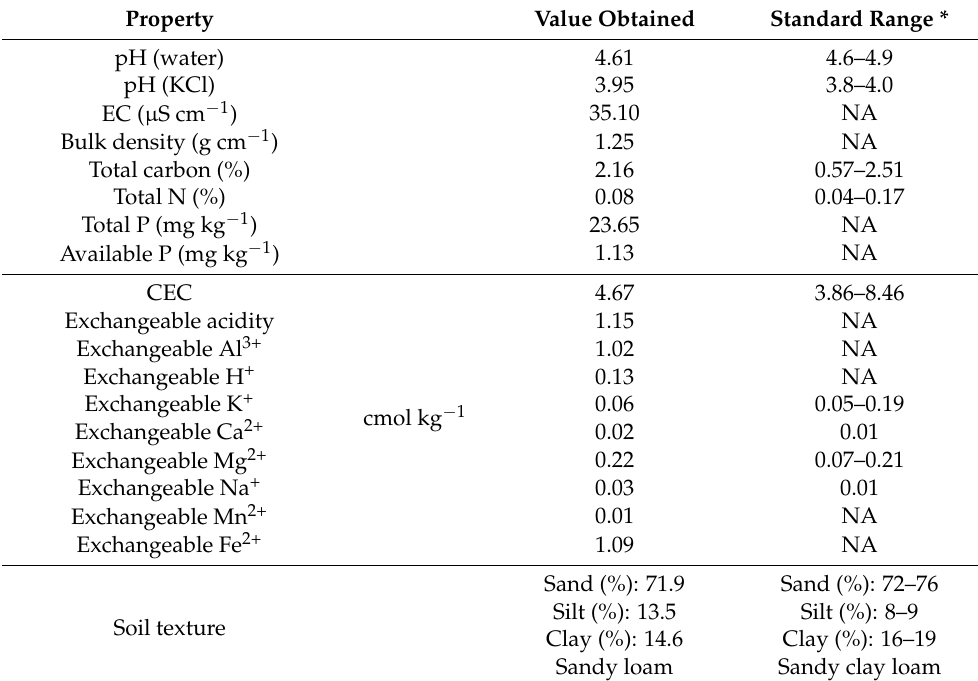
Table 1. Selected physico-chemical properties of the soil used in incubation study.